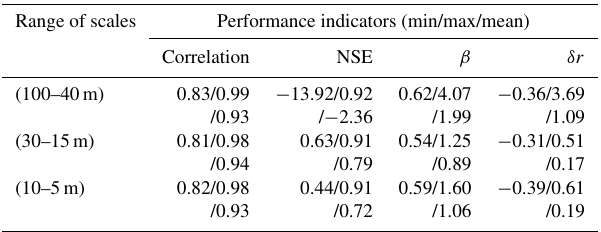
Table 2. Min/max/mean of performance indicators (Correlation, NSE, β and δr ) calculated at three ranges of scale: (100–40m), (30– 15m) and